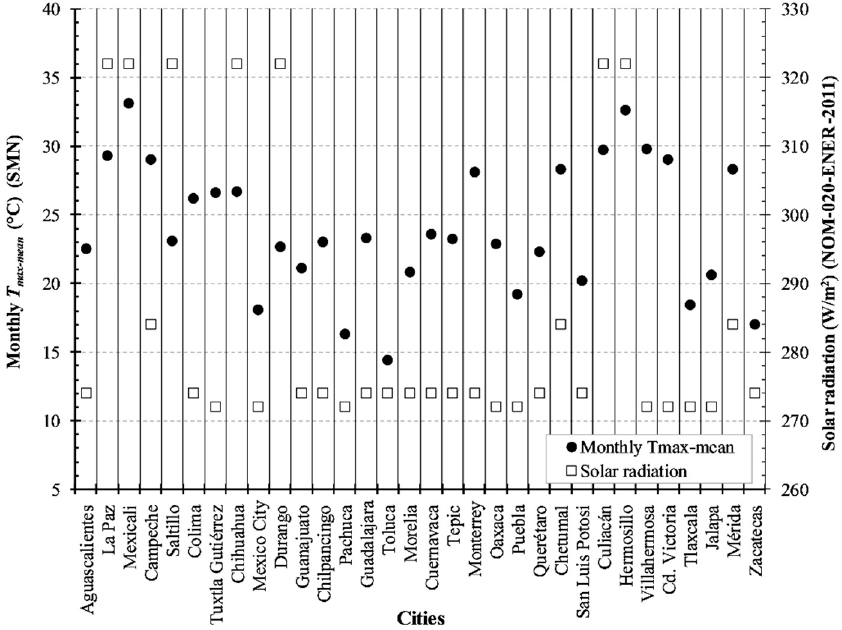
Figure 2. Mean monthly maximum temperature and solar radiation in capital cities in Mexico. SMN: Servicio Meteorologico Nacional (Mexican National Meteorological Service).